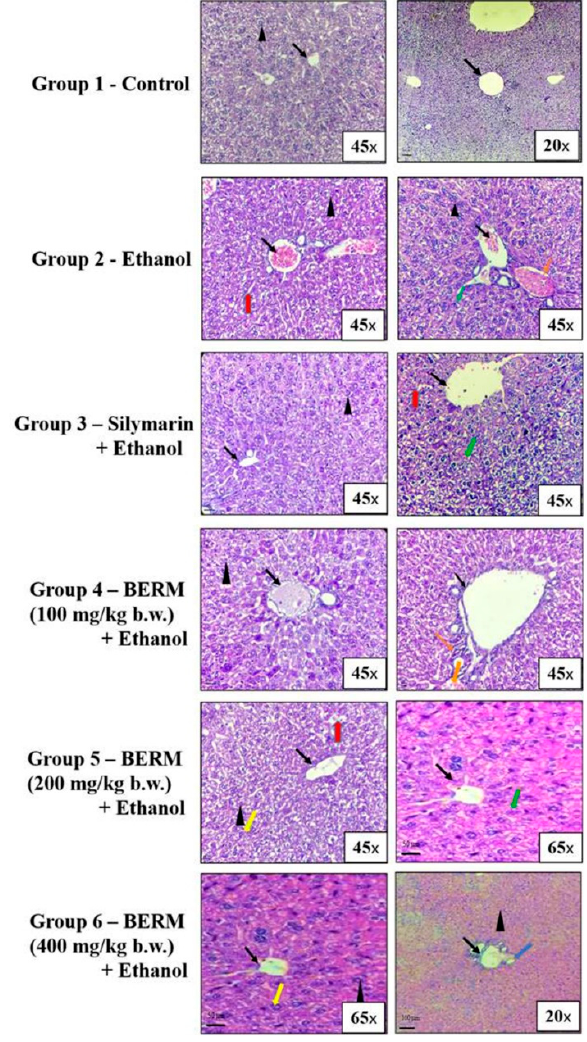
Figure 1. BERM pre-administration prevented ethanol intoxication-induced liver necrosis and injury in mice. Histopathological analysis of representative microsections of liver tissues extracted from the untreated (Group 1—Control) and treated mice (Group 2–6). From Group 2, high-dose ethanol- induced liver damage was observed in the tissues, as indicated by the arrows, pointing at damaged hepatic cells with microvacuolation (black arrowhead), granular cytoplasm (red arrow), and necrosis (orange arrow). Ethanol-induced liver injury was also observed, as indicated by the arrows, pointing at central vein damage (black arrow) and immune cell infiltration (green arrow). From Group 3, the oral pre-administration with Silymarin prevented ethanol-induced liver necrosis and injury as indicated by normal tissue architecture (normal central pointed by black arrow) and less damaged hepatic cells, granular cytoplasm, and cell infiltration. From Groups 4–6, the oral pre-administration with BERM (100–400 mg/kg b.w.) gradually prevented ethanol intoxication-induced liver damage as indicated by the absence of histopathologic alterations (no hepatic microvacuolations, pointed at by a black arrowhead) and areas showing recovery of the nucleus (pointed at by a yellow arrow) and normal hepatic artery (pointed at by the blue arrow), as compared to the Group 1 presenting no damage of the liver tissue, confirmed by normal hepatic cells (black arrowhead) and central vein (black